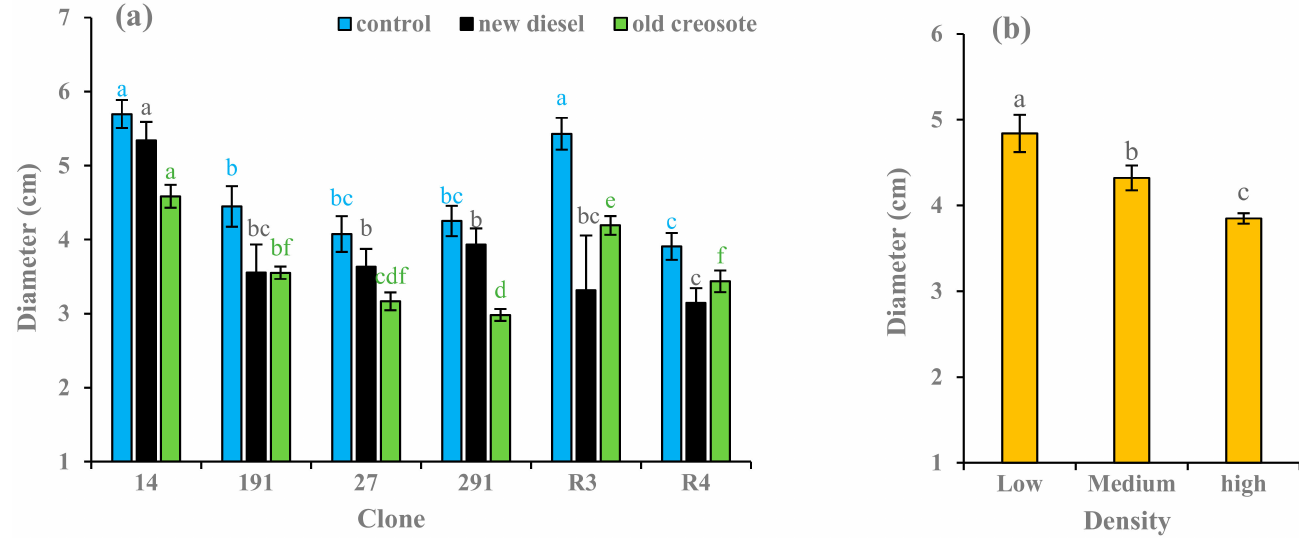
Figure 4. Average ( n = 3) diameter (cm) of European aspen and hybrid aspen clones grown in different soil treatments ( a ) and plant densities ( b ). Error bar indicates ± standard error (SE). Means between clones followed by the same lower-case letters with the same font color are not significantly different ( p > 0.05). Means between density treatments followed by the same lower-case letters are also not significantly different ( p >